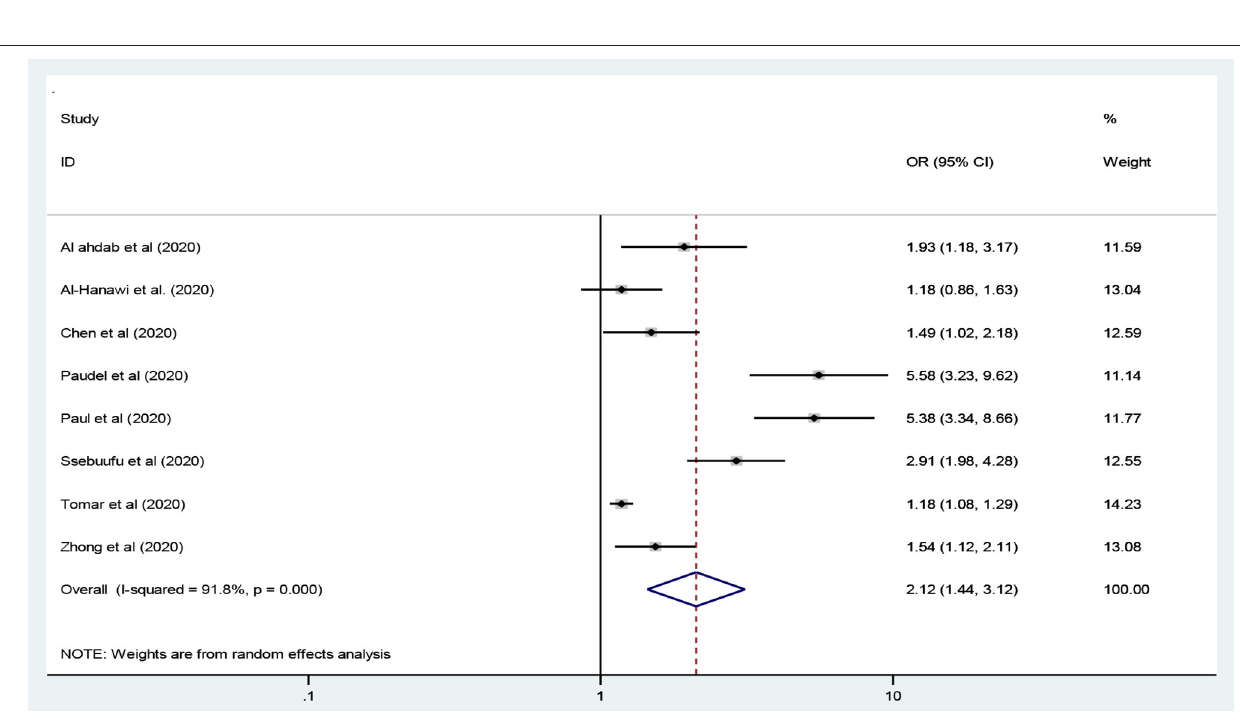
FIGURE 8 | Employment status and preventive practice toward